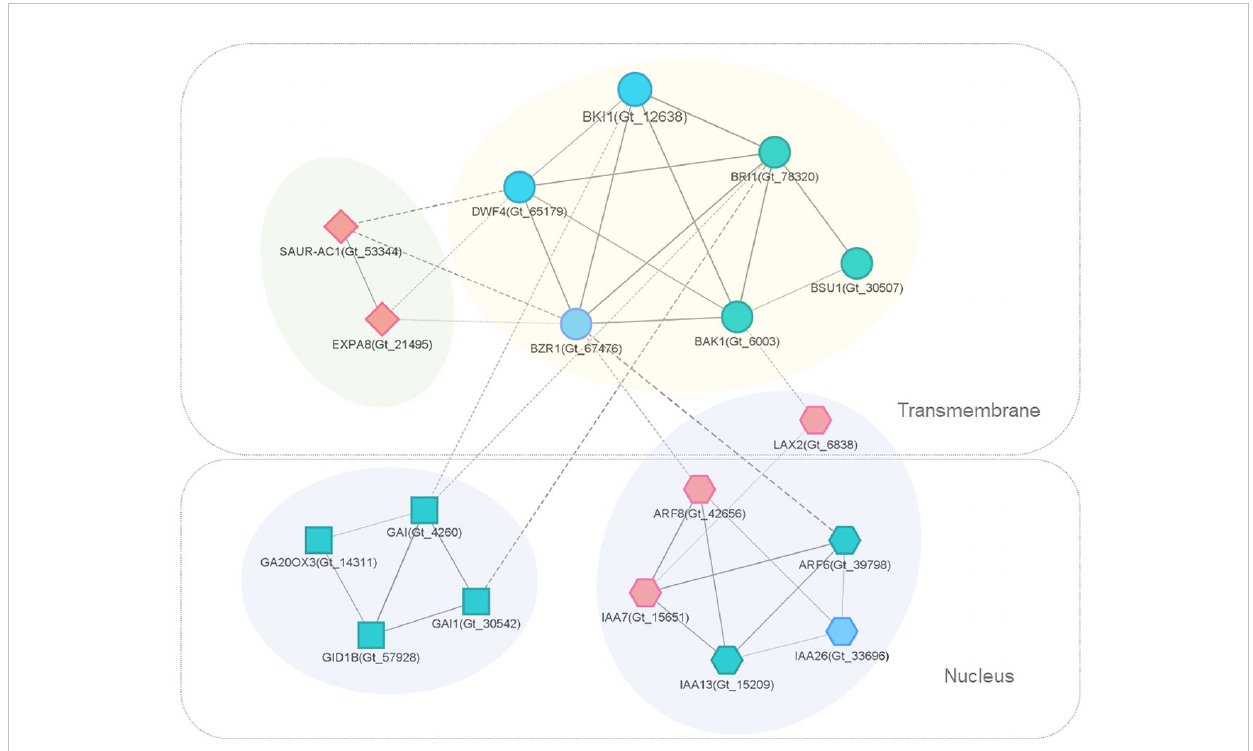
FIGURE 6 PPI subnetworks of key DEGs and related genes involved in BR (circular), auxin (hexagon), GA (square), and other important (diamond) signaling. Nodes represent proteins (genes), edges represent connections, and edge width represents the STRING interaction score. Solid and dash lines indicate within and between cluster interactions, respectively. For clear presentation, only edges with score ≥ 0.5 were presented. Different node colors indicate genes with signi fi cantly up-regulated (red), down-regulated (blue) or similar (grayish green) expression levels in the comparison of L- morph vs. S-morph styles (middle